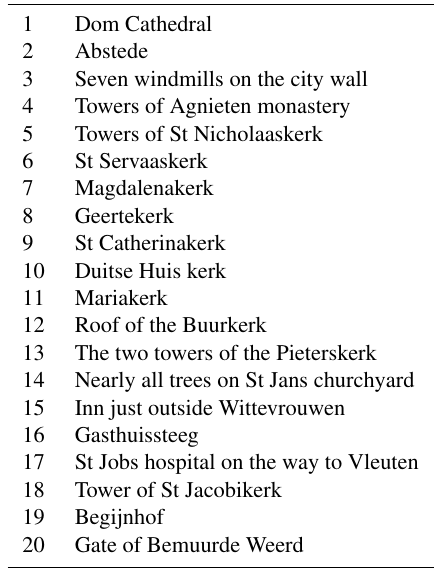
Table 1. Detailed damage reports within the city of Utrecht and its immediate surroundings. Numbers refer to locations on the map of Fig.